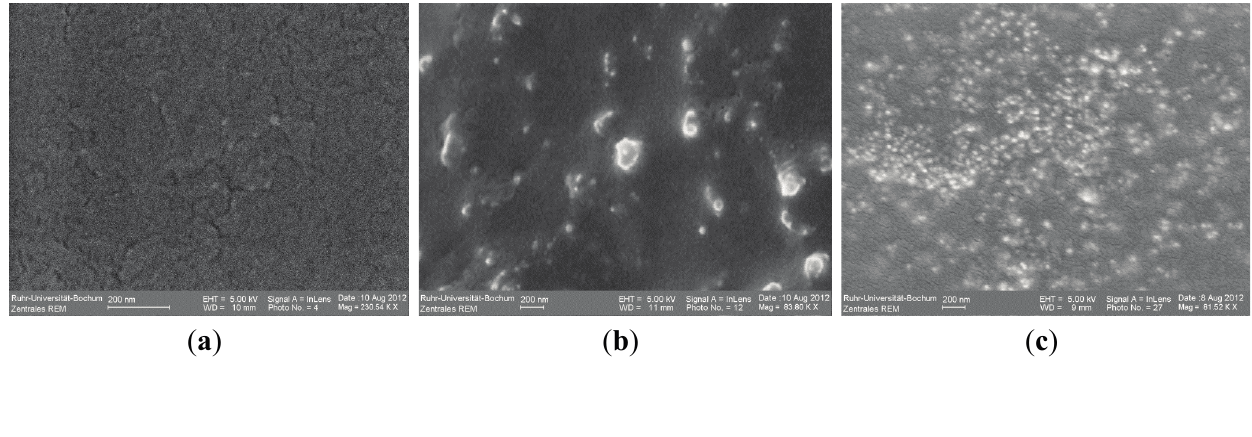
Figure 11. Nanoparticles dispersion at concentration ( a ) 0.001 wt %, ( b ) 0.1 wt % and ( c ) 2.0 wt